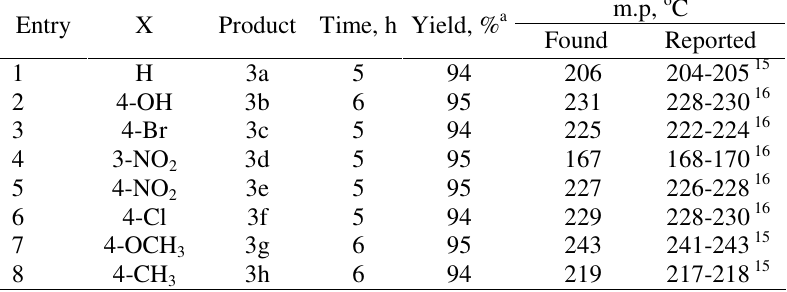
Yields refer to isolated